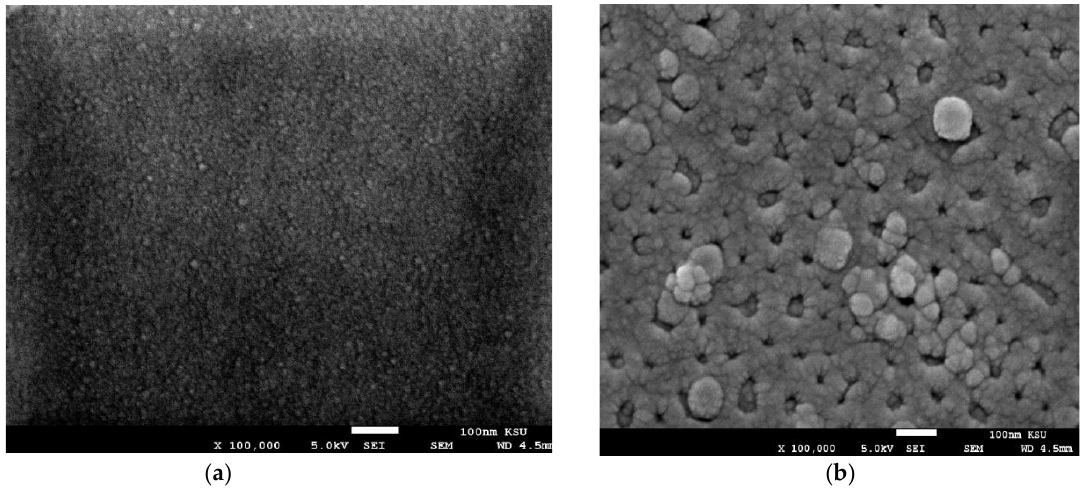
Figure 10. FESEM images of ( a ) as-deposited and ( b ) annealed compound 4 thin films. The magnification is 100,000X, and the bar scale is 100 nm. The focal length of the objective lens is WD= 4.5 nm.